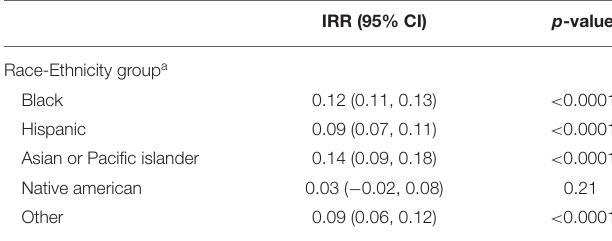
TABLE 5 | Multivariate analysis of length of stay, by race-ethnicity group.